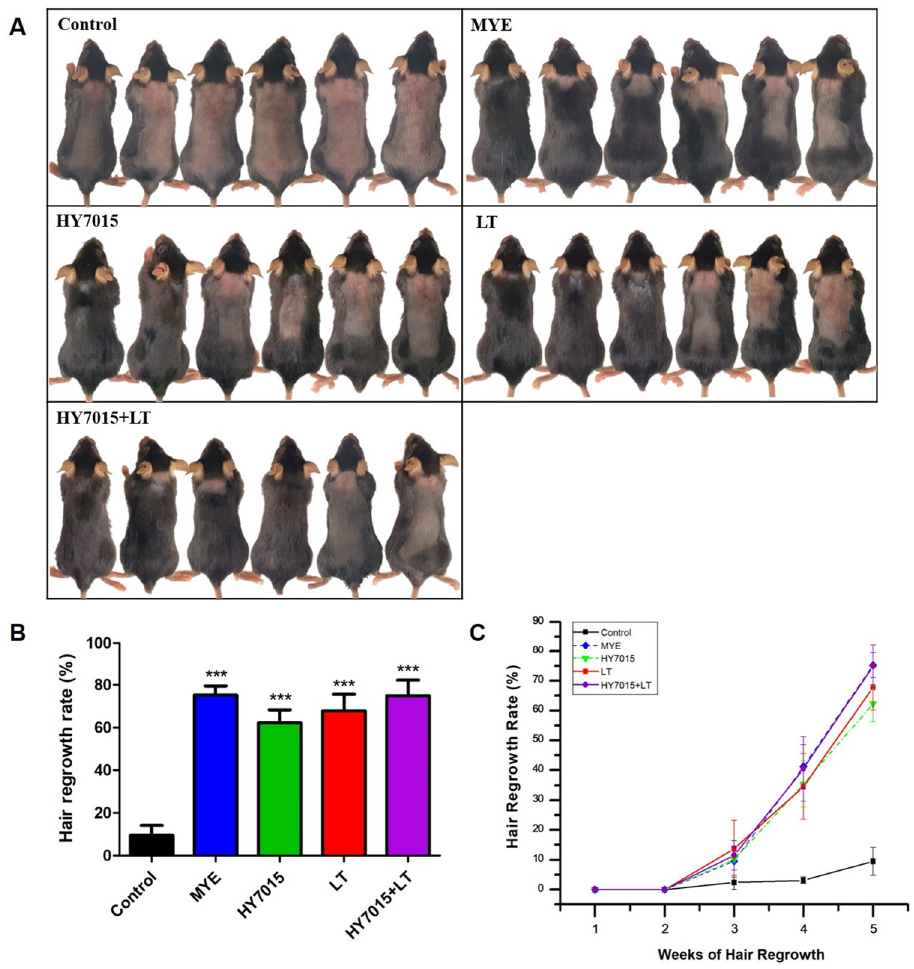
Figure 4. Effect of Lactobacillus paracasei HY7015 (HY7015) and/or Lycopus lucidus Turcz. (LT) extract on promoting hair regrowth in a telogenic mouse model. Shaved 7-week-old mice were fed a normal control diet (Control), or medicinal yeast extract (MYE, 200 mg/kg), or HY7015 (1 × 10 8 CFU/day) and/or LT extract (100 mg/kg) daily for 5 weeks. ( A ) Photographs of mouse dorsal skin by groups at week 5. ( B ) Hair regrowth rates during the 5 weeks period. ( C ) Weekly assessment of hair regrowth rates in each group during the 5 weeks period. Data are presented as mean ± SE. Significant differences are indicated by *** p < 0.001, relative to the control group. SE, standard error; MYE, medicinal yeast extract; HY7015, Lactobacillus paracasei HY7015; LT, Lycopus lucidus Turcz.; HY7015+LT, Lactobacillus paracasei HY7015 with Lycopus lucidus Turcz.